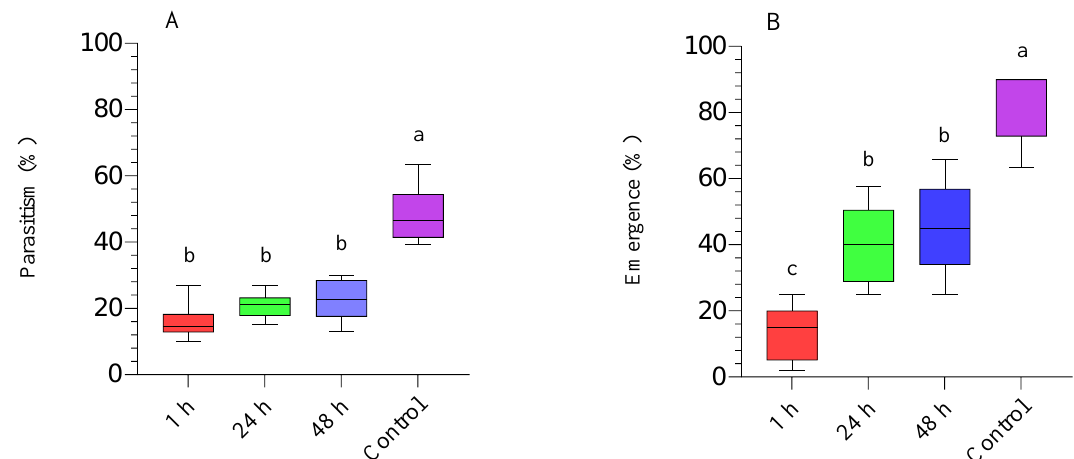
Figure 3. Percentage of parasitism ( A ) and emergence ( B ) of Tamarixia radiata from nymphs where Diaphorina citri first were treated with Beauveia bassiana (BB-12) and subsequently exposed to Tamarixia radiata (parasitoids were released at 1, 24, and 48 h after Beauberia bassiana application). Means followed by the same letter are not significantly different (Tukey, p < 0.05). Table 2. Means and SE of the pre-adult duration, sex ratio and longevity of Tamarixia radiata when Diaphorina citri nymphs were first treated with Beauveria bassiana (BB-12) and subsequently parasitized by Tamarixia radiata . Treatment n ◦ Nymphs Exposed